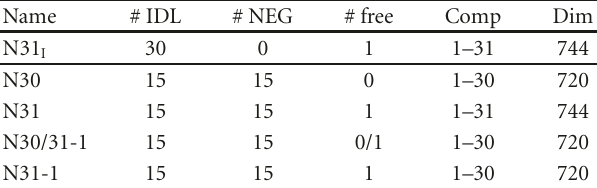
linear regression: o ff set, slope, MSE Figure 1: Results on the INTERSPEECH 2009 Emotion Challenge Table 3: Summary of NMF feature sets for the Aibo 2-class task (FAU Aibo 2-class problem, close-talk speech = CT). “UAR” problem. # IDL: number of characteristic sequences from IDL denotes unweighted average recall. “IS” is the baseline feature set training instances; # NEG: number of characteristic sequences from from the challenge; “N30” and “N31 I ” are supervised and unsuper- NEG instances; # free: number of randomly initialized components; vised NMF features (cf. Table 3); “+” denotes the union of feature Comp: indices of NMF components whose functionals are taken sets. “Mel” are functionals of 26Mel frequency bands and “MFCC” as features; Dim: dimensionality of feature vectors. For N30/31-1, functionals of the corresponding MFCCs (1–12). Classification was no “free” component is used for training instances of clean speech. performed by SVM (trained with SMO, complexity C = 0 . As explained in the text, the N31 I set is not considered for the experiments on additive noise.